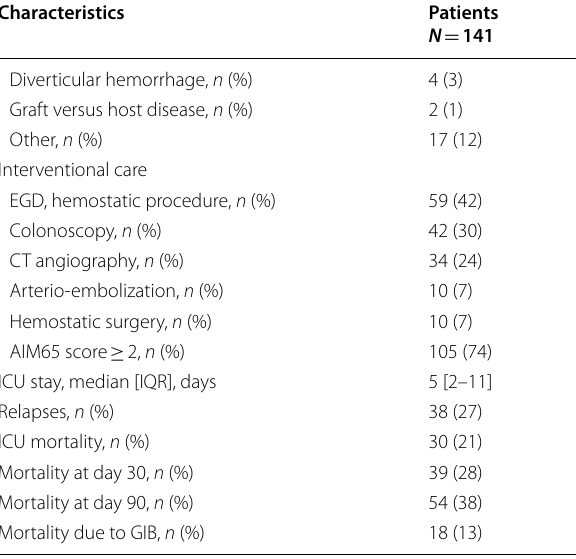
Table 1. The median albumin level during GIB was 26 g/l